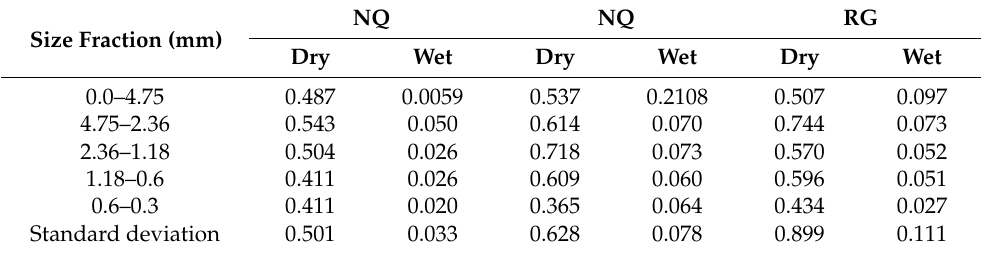
Table 3. Slopes between wet and dry